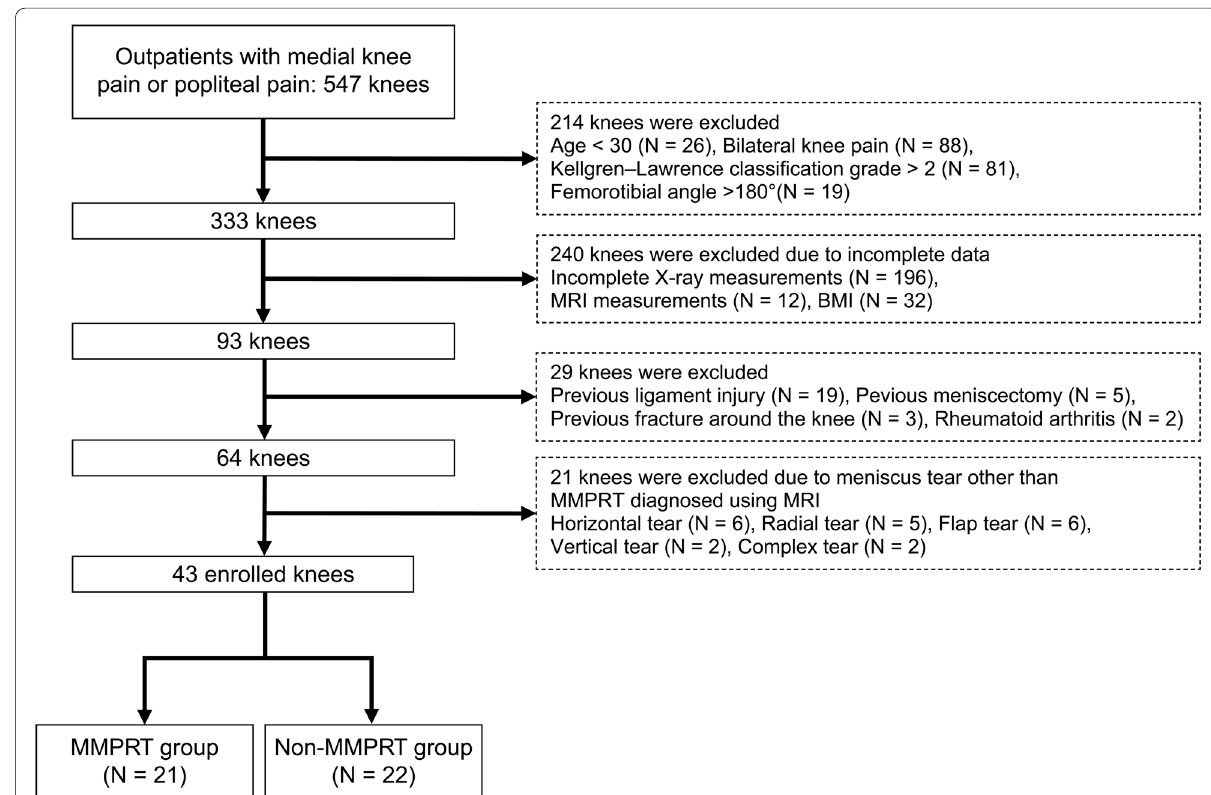
Fig. 4 Flow diagram depicting the knee selection process in the study. MMPRT, medial meniscus posterior root tear; MRI, magnetic resonance imaging